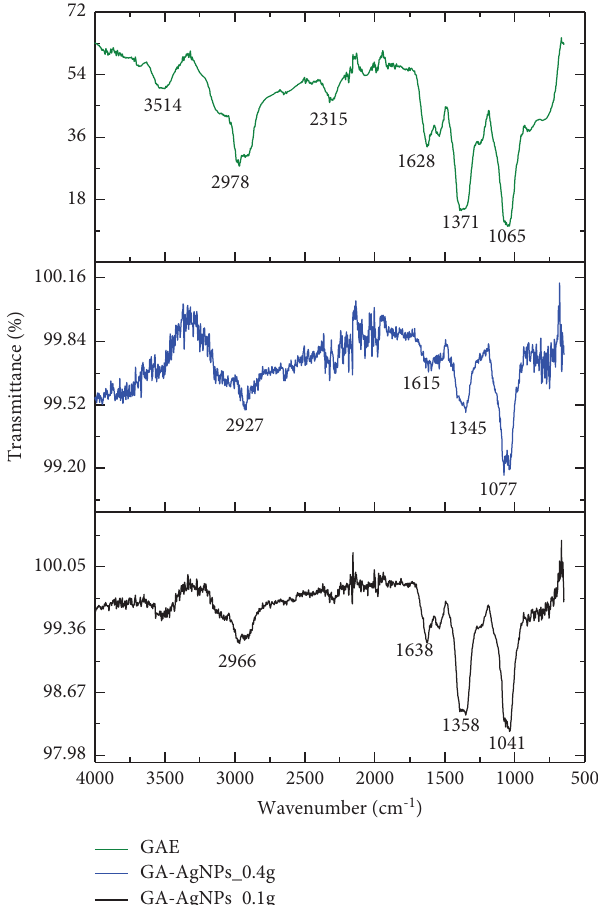
Figure 4: FTIR images of GAE, GA-AgNPs_0.4g, and